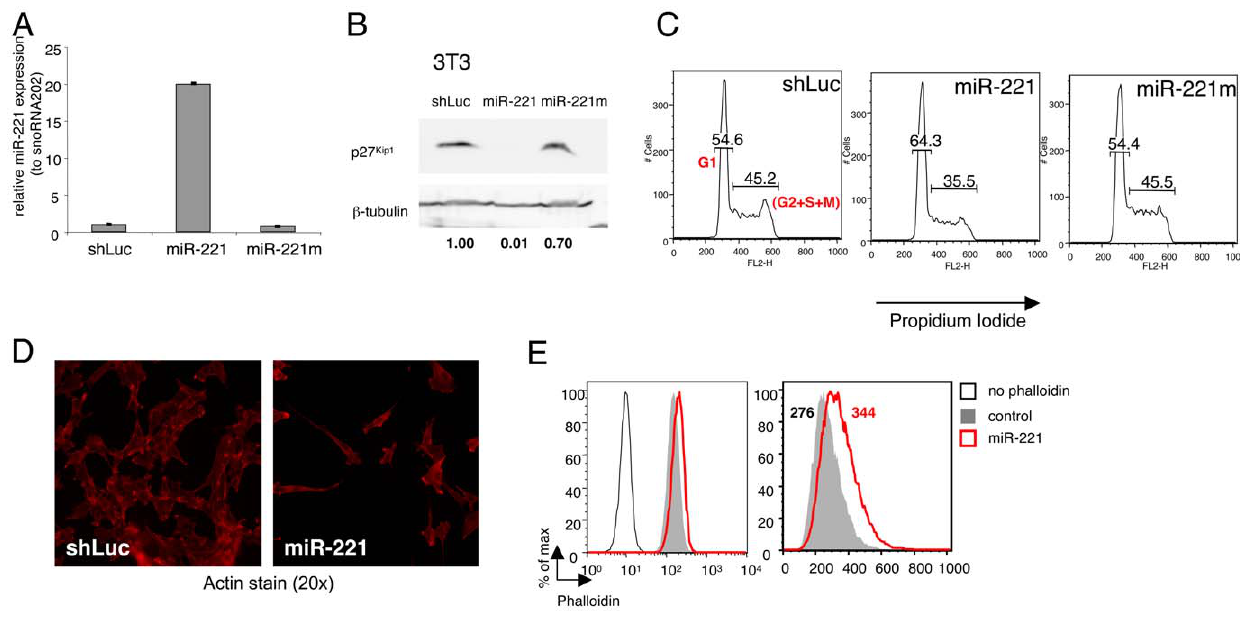
Figure 6. MiR-221 affects cell proliferation and actin cytoskeleton in fibroblasts. A ) 3T3 cells were transduced with lentiviral vectors to express either miR-221 or controls shLuc and miR-221m. After selection with 2 m g/mL for at least 2 days, total RNA was extracted and levels of miR- 221 expression were assessed by TaqMan qRT-PCR. SnoRNA202 was used as endogenous control; for comparison, levels of miR-221 expression in the shLuc-transduced sample were set to one. Representative of two independent experiments. B ) 3T3 cells as in A) were lysed in Laemmli sample buffer and p27 Kip1 expression was analyzed by Western blot. Expression of b -tubulin was used for normalization in the quantification of bands intensity (numbers below the blot). One representative experiment out of 3 is shown. C ) Cells as in A) were collected during exponential-phase growth and the DNA content was assessed with propidium iodide staining as a measure of the number of cells in each stage of the cell cycle. For simplicity, only the percentage of G1 cells (left in each plot) versus the percentage of dividing cells (S + G2 + M) are shown. One out of three independent experiments is shown. D ) Cells as in A) were seeded on a coverslip and allowed to adhere overnight, after which they were fixed in 4% paraformaldehyde and stained with phalloidin-AlexaFluor-594 prior imaging with a fluorescent microscope. Shown is one representative experiment out of two. E ) Cells as in A) were trypsinized to single cell suspension, fixed and stained as in B) and analyzed by FACS. The left plot shows (on a log scale) the unstained control compared to stained samples, while on the left the scale was changed to linear to better show the differences among samples. The MFI for each sample is also provided. Depending on the experiment, control cells were either untransduced cells, cells transduced with shLuc- or the miR- 221m-expressing vector, or all of the above. Shown is one representative experiment out of